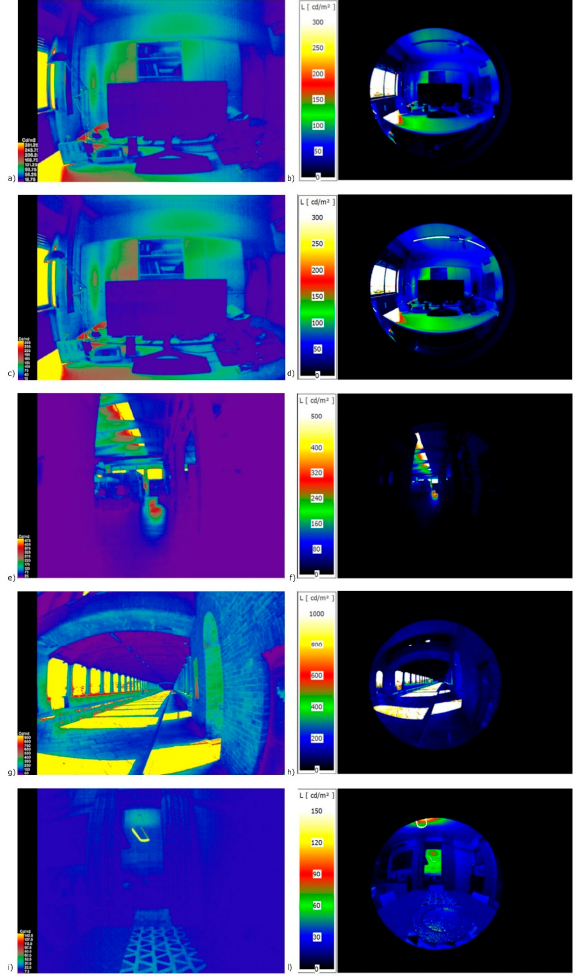
Figure 11. False-colour distribution of luminance in different scenarios: (a) office space with low- cost camera—Daylight; (b) office space with the professional camera—Daylight; (c) office space with